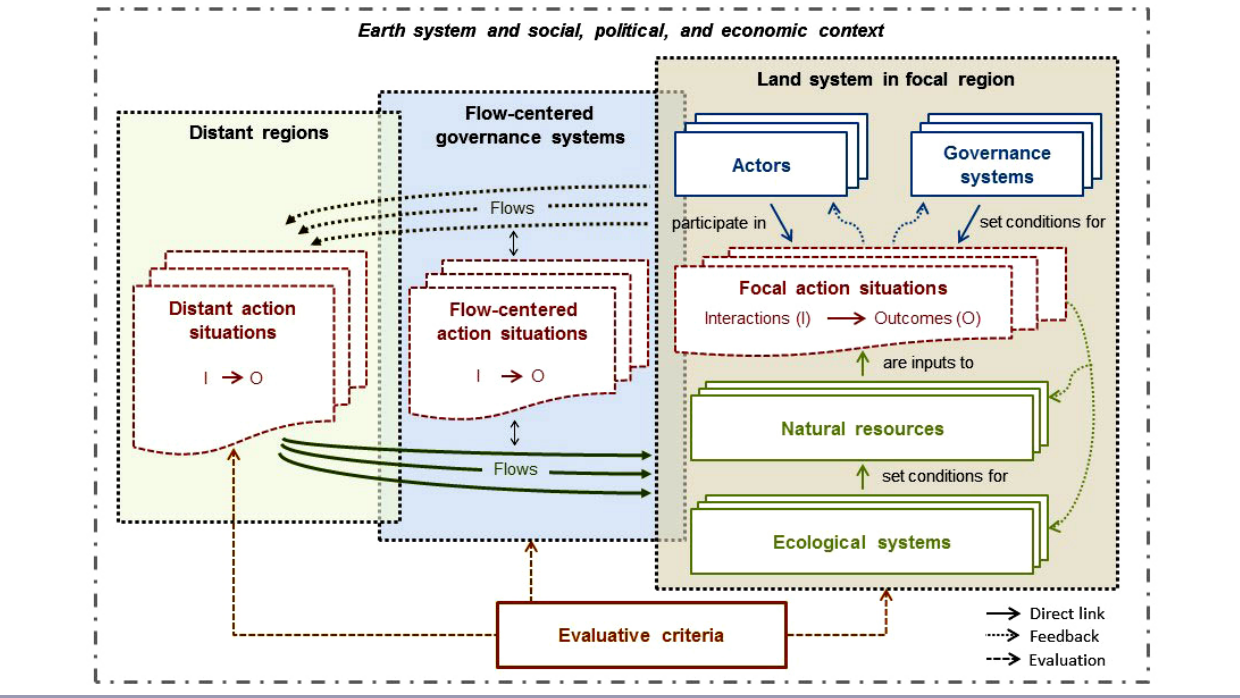
Fig. 1 . Framework linking the concepts of telecoupled social-ecological systems and polycentric